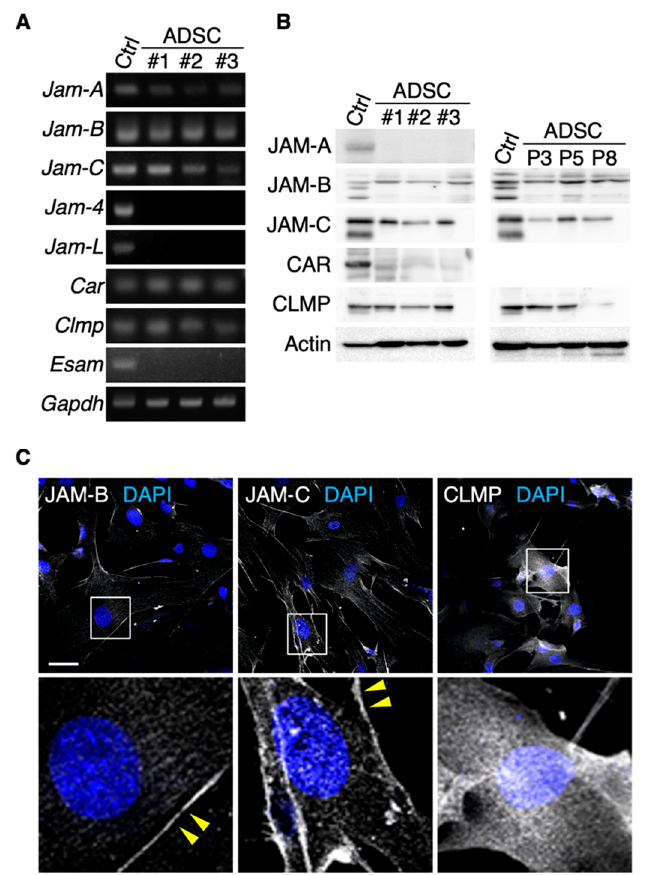
Figure 1. JAM-B and JAM-C are concentrated on cell membranes of mouse adipose-derived stro- mal/stem cells (ADSCs). RT-PCR ( A ) and Western blot ( B ) for the indicated molecules in ADSCs derived from three mice (#1–3). Mouse kidney (for Jam-4 ) and spleen tissues (for other junctional adhesion molecules; JAMs) are used as positive controls (Ctrl). P, passage. ( C ) Confocal images of ADSCs stained for the indicated markers. Arrowheads show JAM-B- and JAM-C-immunoreactive signals on the cell membranes of ADSCs. Squares indicate the enlarged areas. Scale bar, 50 µm.